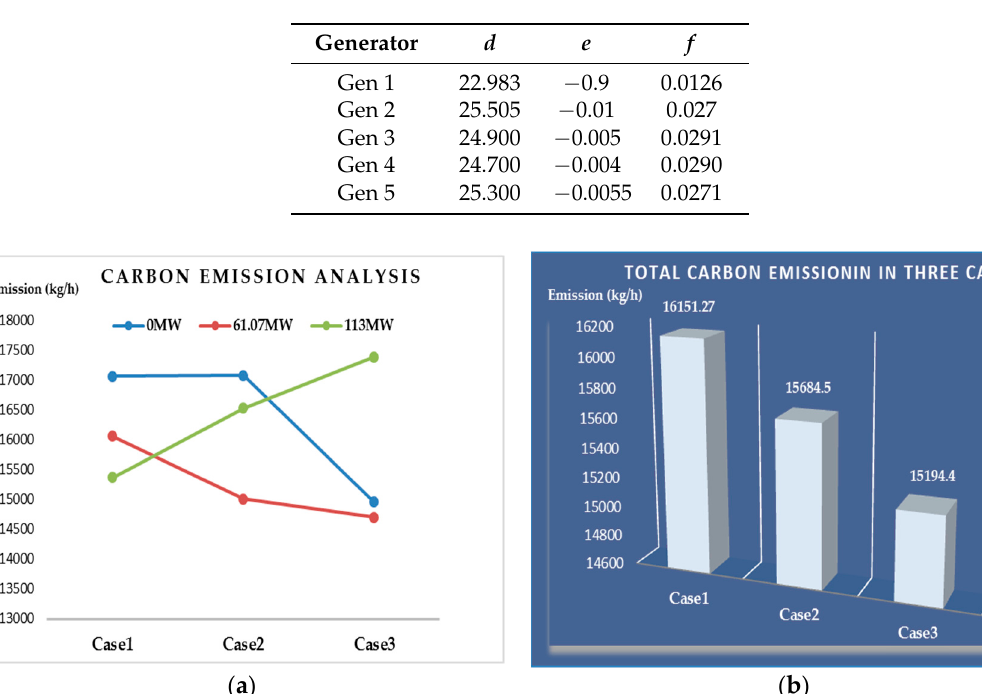
Table 3. Carbon emission parameters of diesel engines.